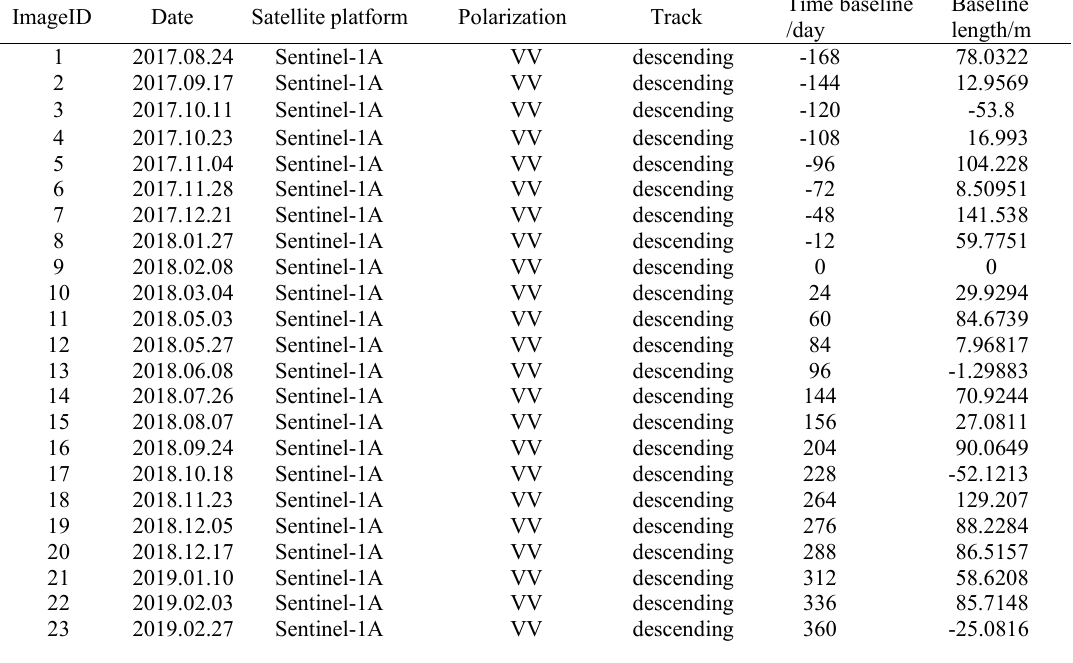
Table 2 . The image parameter information of